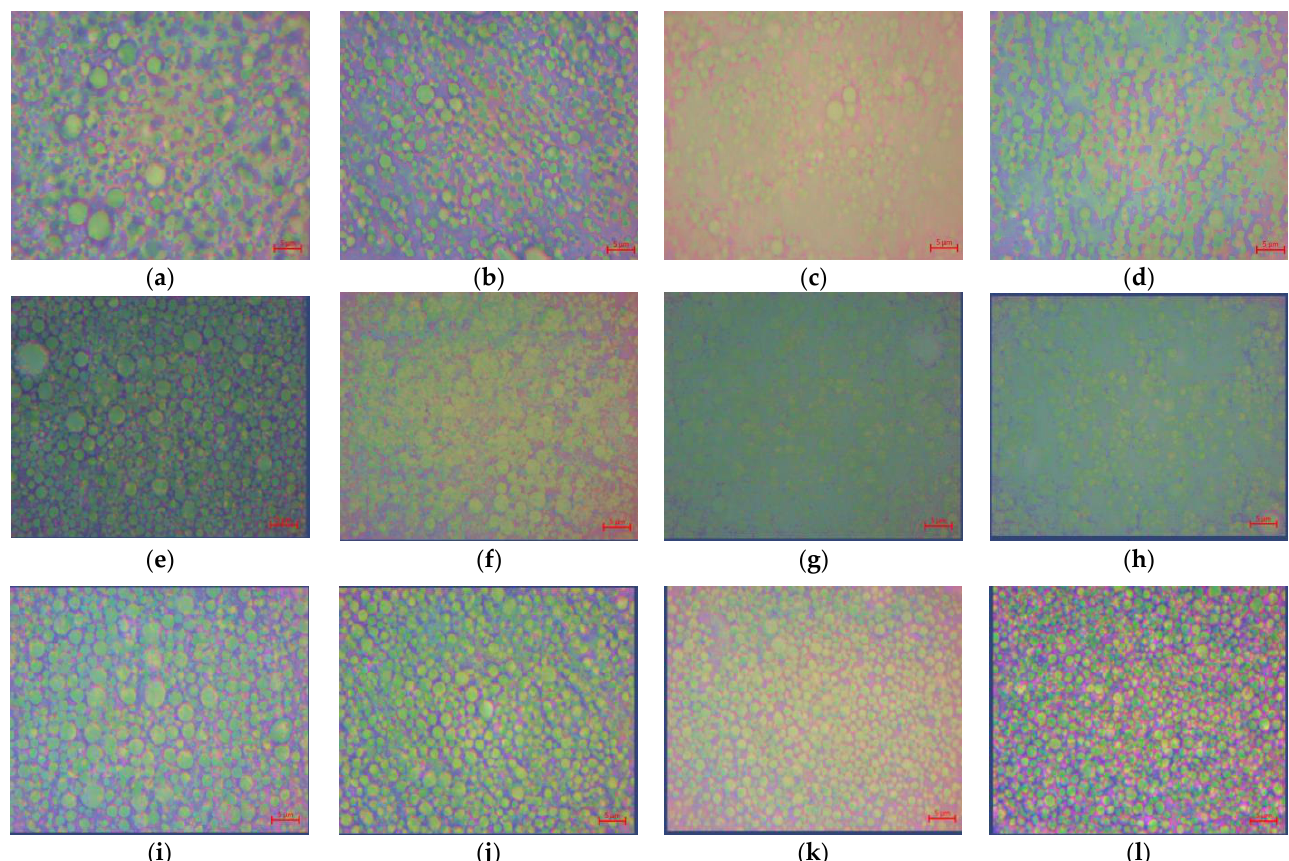
Figure 6. Microstructure and mean diameter size of carboxymethyl cellulose/mango-starch emulsion gels with 1% w/w of mango peel extracts. ( a ) EG10-MS (4.64 ± 0.83 μ m), ( b ) EG10-MS0.5 (2.52 ± 0.21 μ m), ( c ) EG10-MS1.0 (1.72 ± 0.39 μ m), ( d ) EG10-MS1.5 (1.30 ± 0.26 μ m), ( e ) EG20-MS (3.87 ± 0.18 μ m), ( f ) EG20-MS0.5 (3.48 ± 0.69 μ m), ( g ) EG20-MS1.0 (2.94 ± 0.34 μ m), ( h ) EG20-MS1.5(1.76 ± 0.11 μ m), ( i ) EG30-MS (3.92 ± 0.23 μ m), ( j ) EG30-MS0.5 (2.75 ± 0.25 μ m), ( k ) EG30-MS1.0 (1.93 ± 0.26 μ m) and ( l ) EG30-MS1.5 (1.66 ± 0.06 μ m).